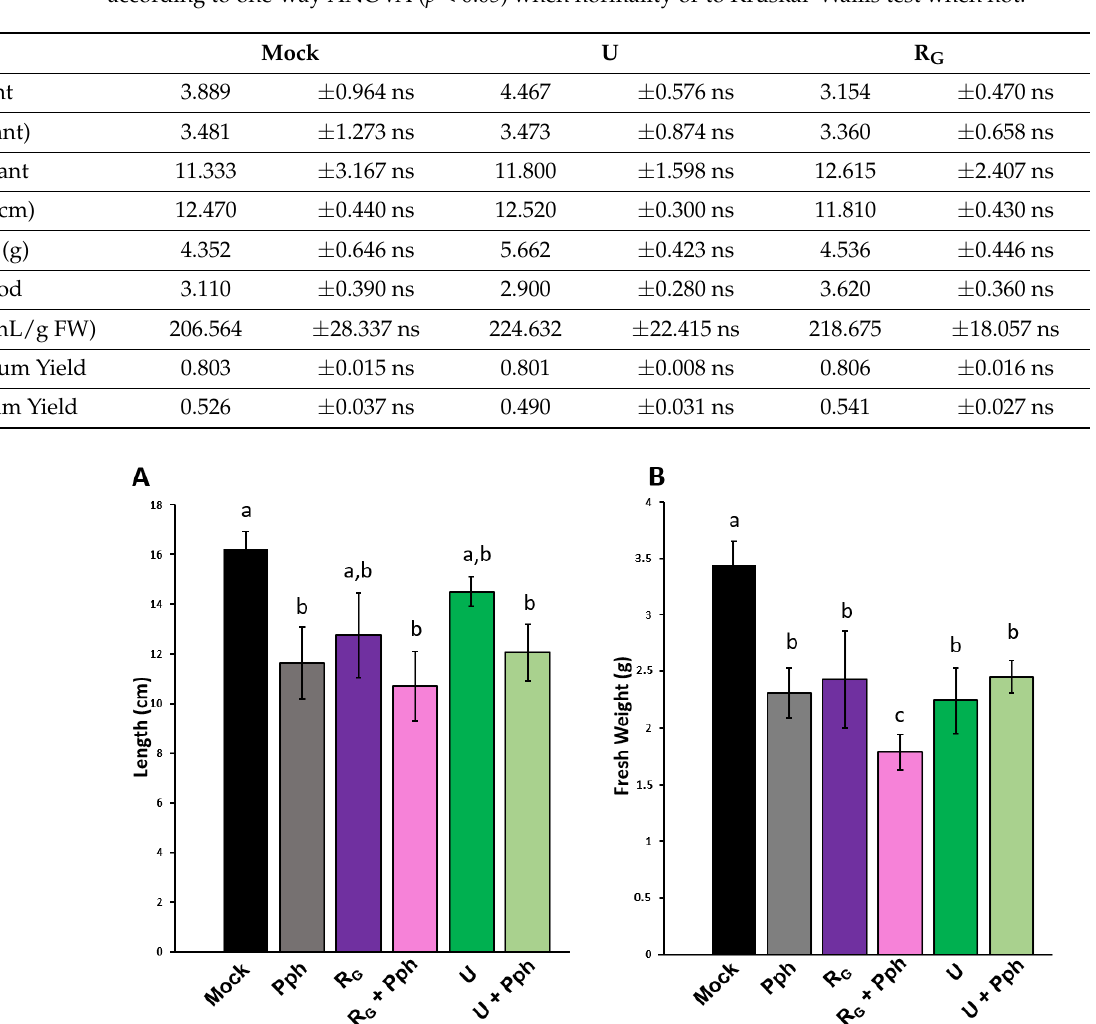
Table 2. Yield and photosynthetic parameters measured in common bean after treatments with U and R G -PBPs. Data shown are the mean ± SE ( n = 12). Statistically significant differences were analyzed according to one-way ANOVA ( p < 0.05) when normality or to Kruskal–Wallis test when not.